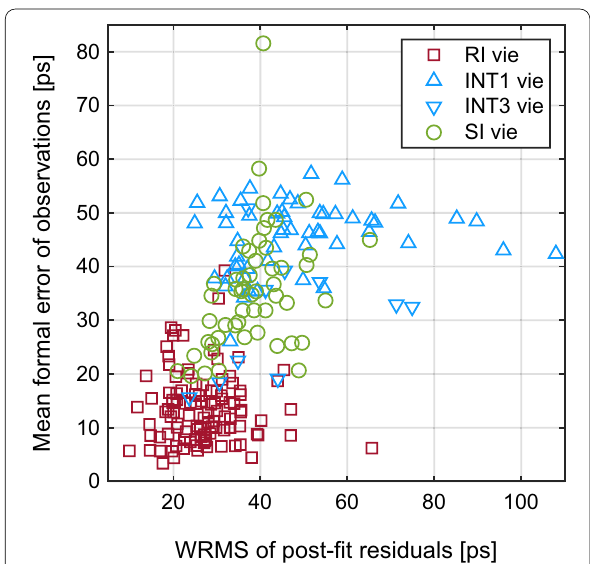
Fig. 3 WRMS (weighted root mean square) of post-fit residuals [ps] from VieVS analysis versus mean formal error of observations [ps] from original databases